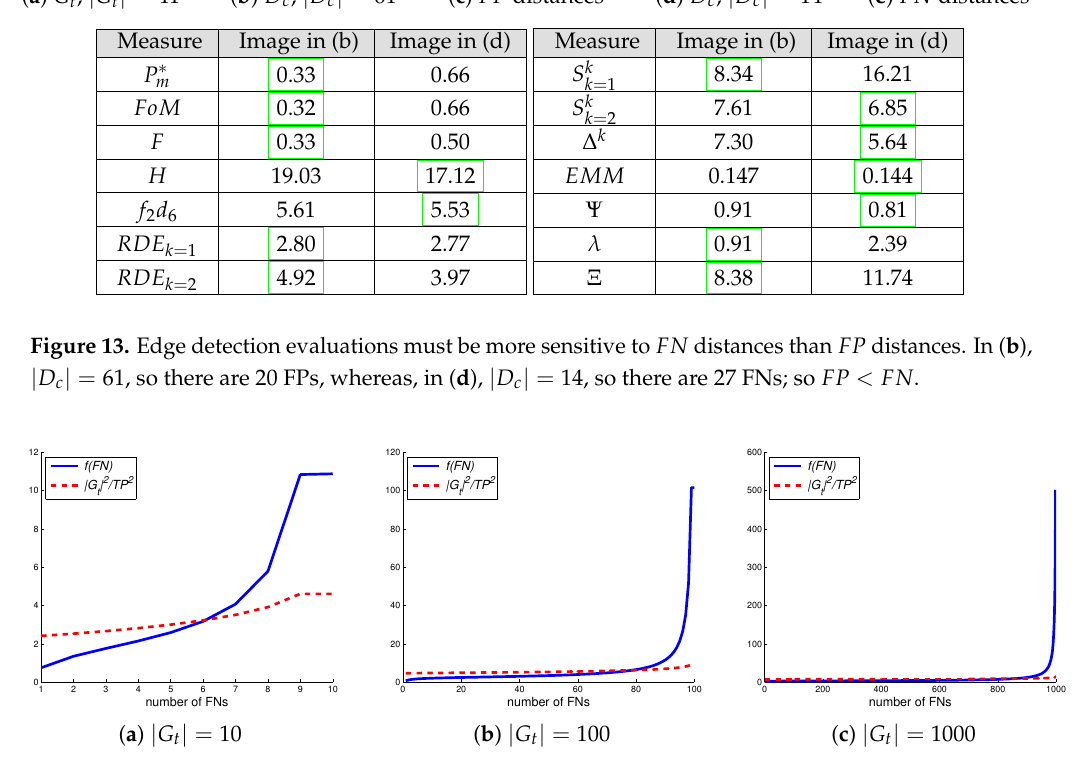
Figure 14. Several examples of f function evolution as a function of the FN